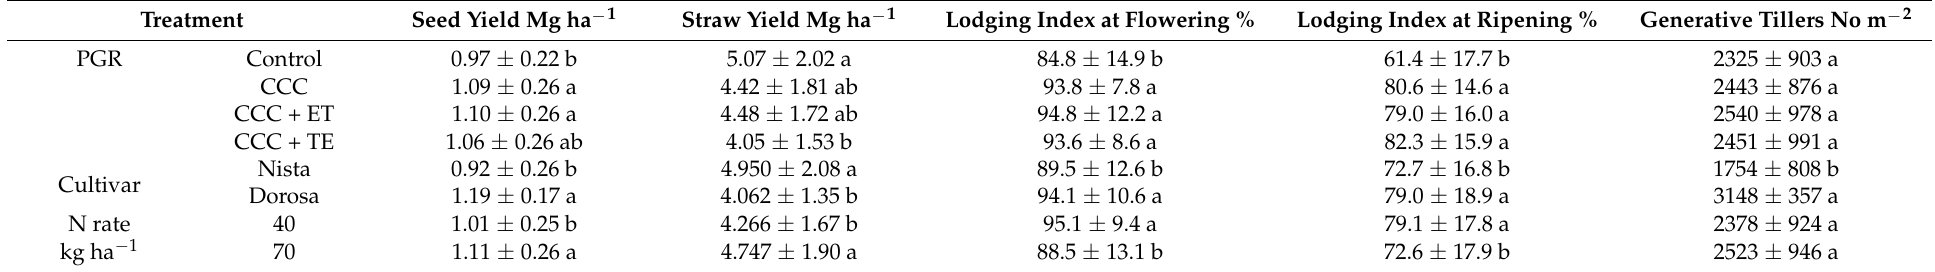
Table 8. Seed and straw yield, lodging index (canopy height to tiller length ratio) at flowering and at ripening, and the number of generative tillers of red fescue ( Festuca rubra ssp. rubra cv. Nista and F . r . ssp. commutata cv. Dorosa), means for two production years, and two field